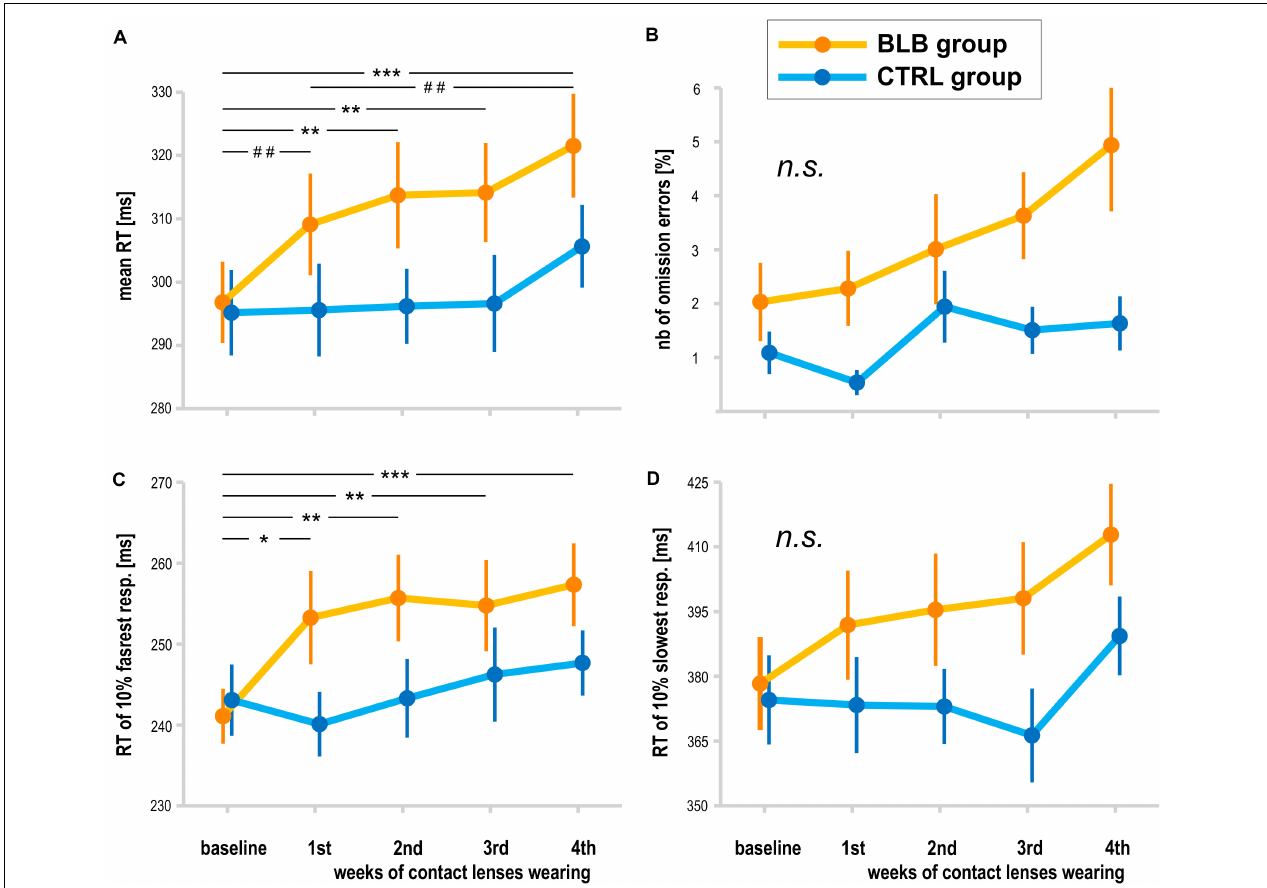
FIGURE 4 | Psychomotor vigilance task (PVT) outcomes for the blue light blocked (BLB) and control (CTRL) groups for the baseline and 4 weeks of experimental condition: (A) mean reaction time, (B) number of omission errors, (C) reaction time for 10% of the fastest responses, and (D) reaction time for 10% of the slowest responses. *** p < 0.001; ** p < 0.01; * p < 0.05; ## p < 0.1; bars indicate standard error.